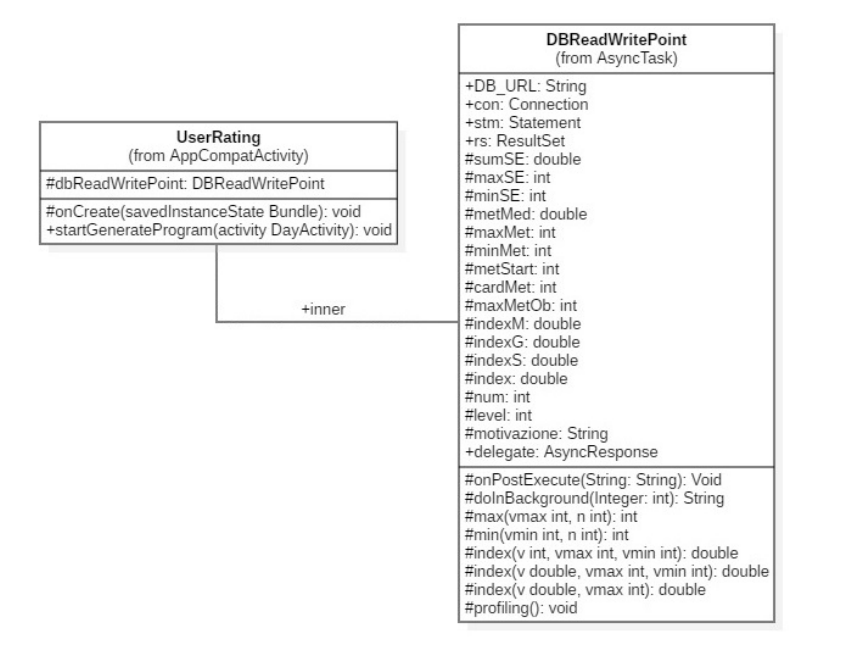
Figure 2. Classes added the MoveUp UML diagram to deal with profiling.